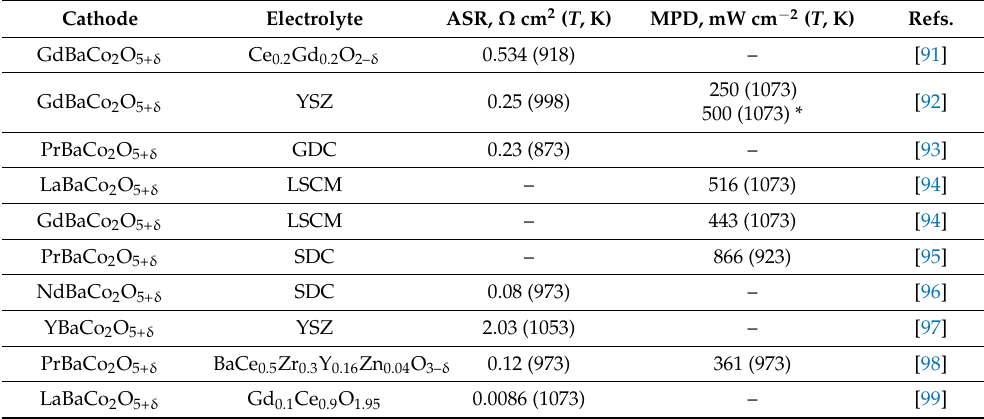
Table 3. Performance (ASR: area specific resistance, MPD: maximal power density) of SOFCs based on REE–barium layered double cobaltites.